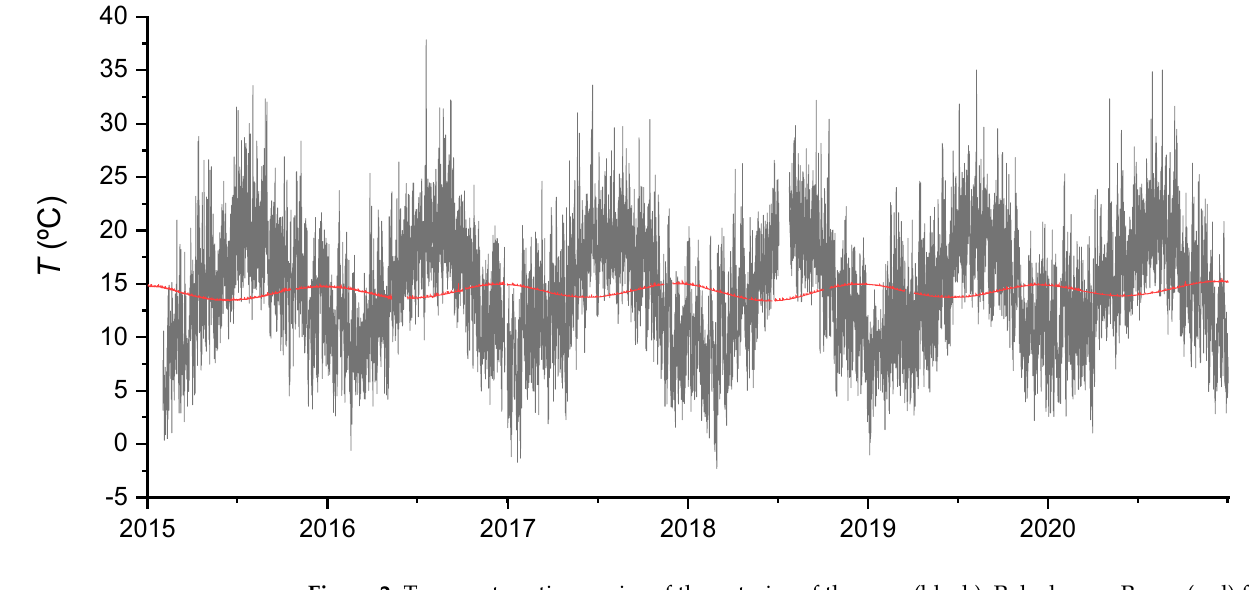
Figure 2 . Temperature time series of the exterior of the cave (black), Polychrome Room (red) from 2015 to 2020.